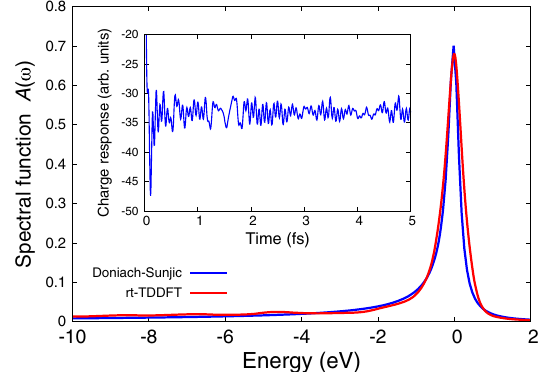
FIG. 7. Spectral function for the Fe 2 p core-excited state in BaFe 2 As 2 due to secondary electronic excitations. The red curve is the result from a rt-TDDFT calculation as described in the text. The blue curve is a Doniach-Sunjic line shape with an asymmetry parameter of 0.14 and a linewidth of 0.16 eV. Inset: real-time valence charge density response to the sudden creation of a core hole at a Fe